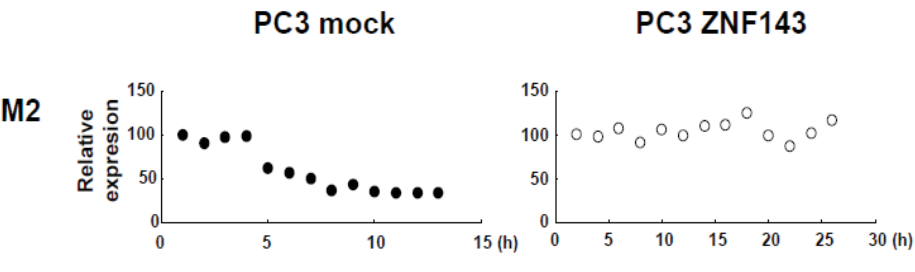
Figure 5. Fluctuations of nuclear expression of MCM proteins. Nuclear MCM2, MCM3, MCM5, MCM6 and MCM7 protein expression levels in Figures 2 and 3 were quantified using Multi Gauge Version 3.0. Closed circles and open circles indicate PC3 mock transfected and PC3 cells with forced expression of ZNF143,